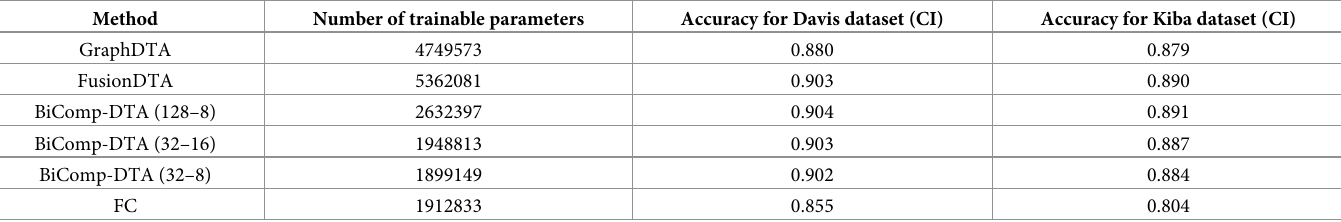
Table 10. Comparing the BiComp-DTA against the alternative methods, i.e. GraphDTA, FusionDTA, and FC, in terms of the number of trainable parameters, and the corresponding accuracy values for Davis and Kiba datasets